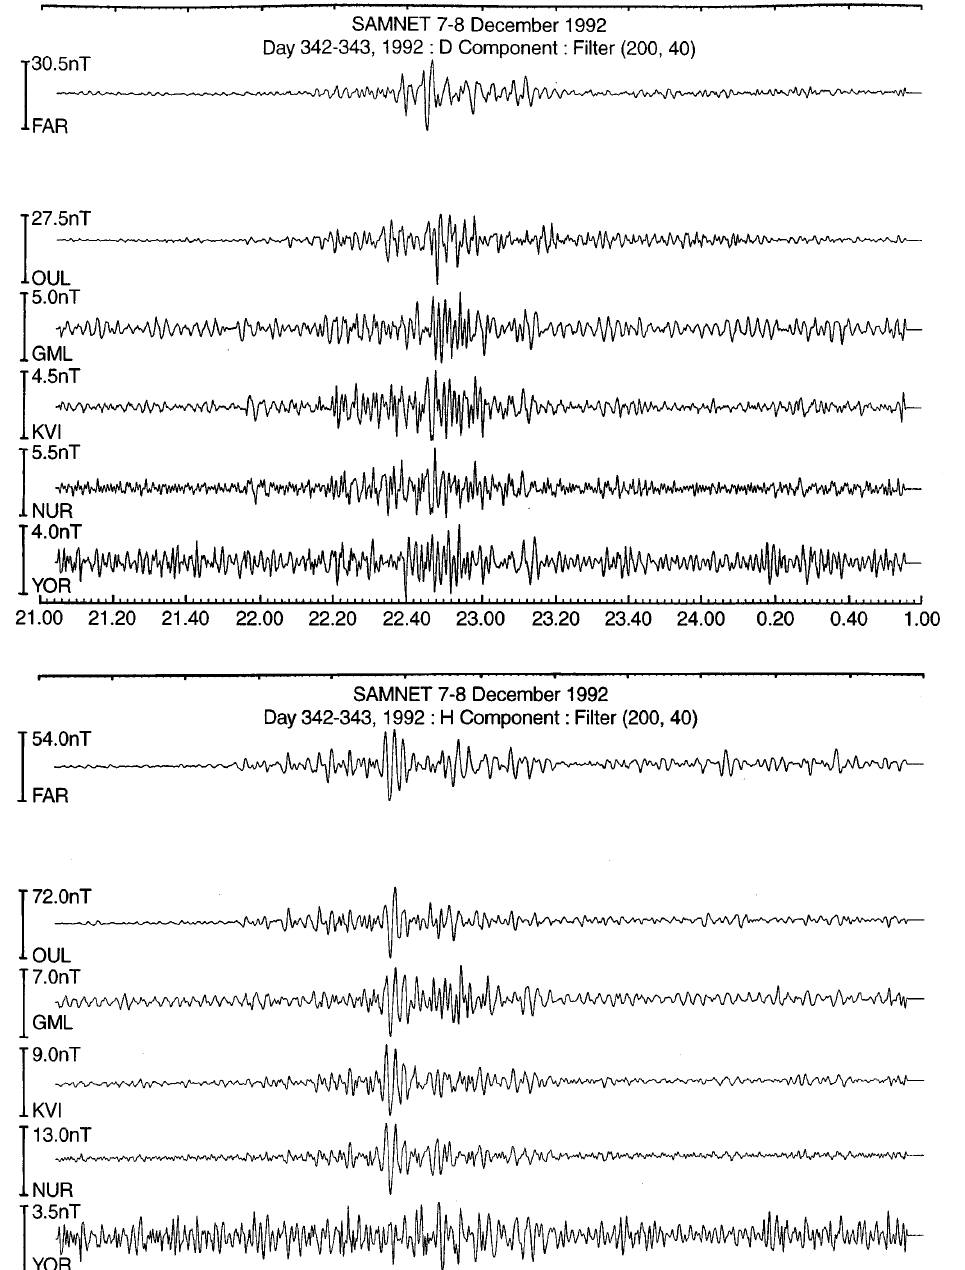
Fig. 5. Data from the SAM- NET magnetometers for 21 UT, 7 December 1992–01 UT, 8 December 1992. The data are the filtered H ( upper panel ) and D ( lower panel ) components of the magnetic field, using a band-pass filter between 40 and